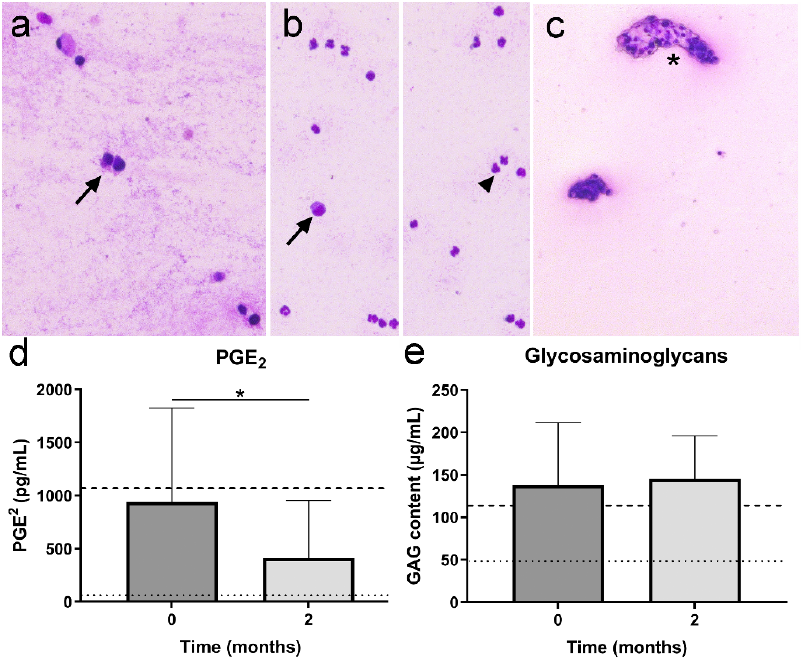
Figure 6. Results of the synovial fluid (SF) analysis prior to (T = 0) and at two-month follow up upon intra-articular injection with triamcinolone acetonide-loaded microspheres. ( a ) Synovial aspirate of dog five, six months after treatment. A few synoviocyte-like cells are present (arrow). ( b ) Cytological smear of SF of dog 3, six months after treatment. Abundant polymorphonuclear cells are present (arrowhead), along with some macrophage-like cells (arrow). No (intra)cellular bacteria were found. ( c ) Contact smear of the SF of dog 1 prior to treatment. Clusters of synovial lining cells are present (asterisk). Concentrations of ( d ) prostaglandin E 2 (PGE 2 ), ( e ) glycosaminoglycans (GAGs) in SF before and two months after intra-articular injection with triamcinolone-acetonide-loaded microspheres. Dotted lines indicate SF control samples of six healthy joints, dashed lines indicate average SF biomarker values for osteoarthritic joints of 6 donors. * Indicates significant difference ( p < 0.05).